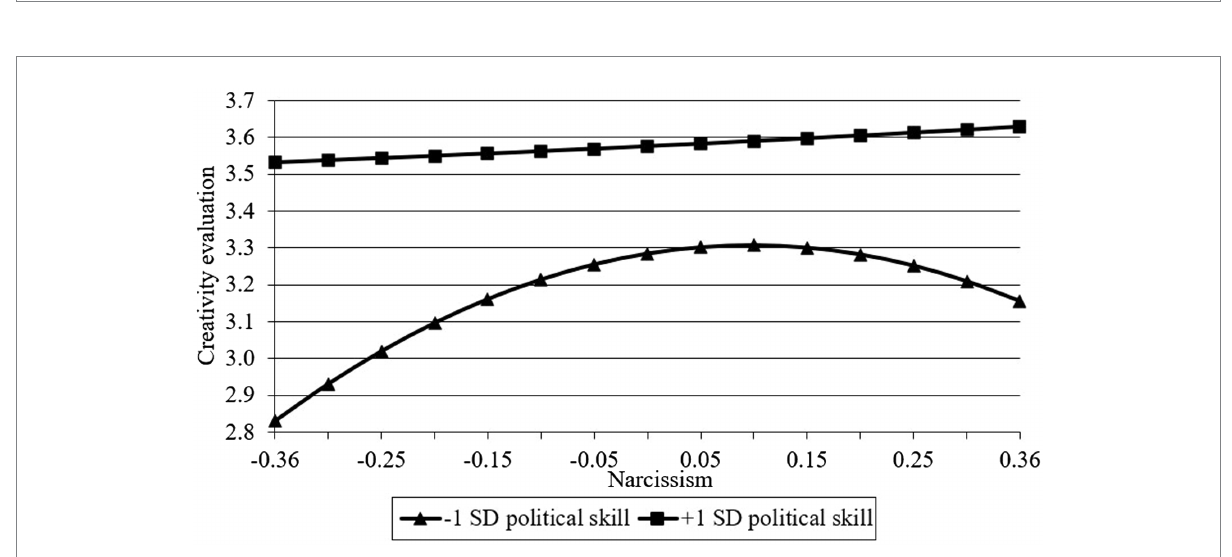
FIGURE 4 The moderating effect of political skill on the relationship between narcissism and creativity